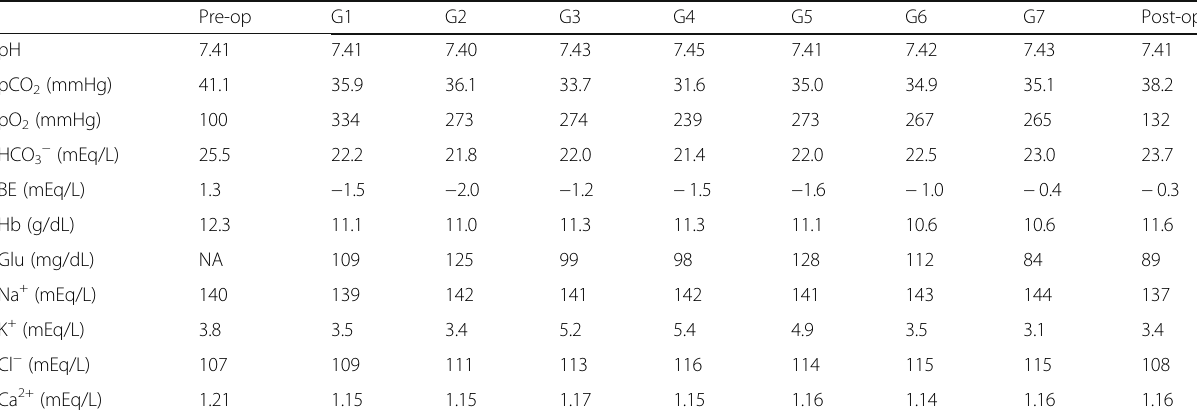
Table 1 Results of arterial blood gas